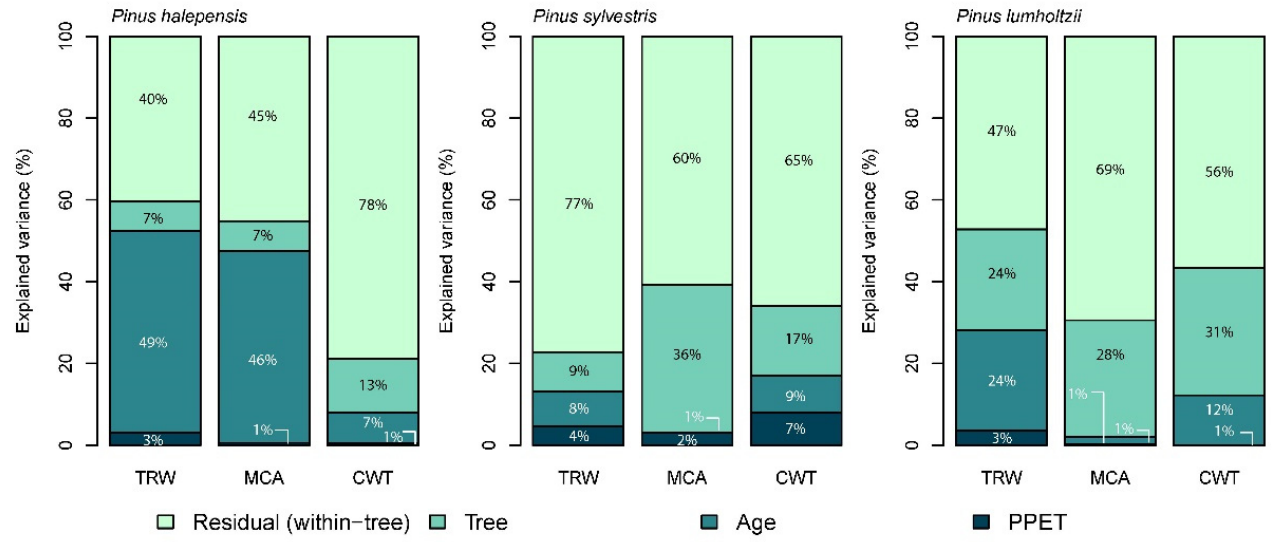
Figure 6. Variance in tree-ring width (TRW) and wood anatomical variables (MCA, mean conduit area; CWT, cell-wall thickness) explained by variation in seasonal water balance (PPET) between individual trees, and age for P. halepensis , P. sylvestris , and P. lumholtzii . Tree represents individual trees, and Age is the individual cambial age. Unexplained variance attributable to residuals is also reported.